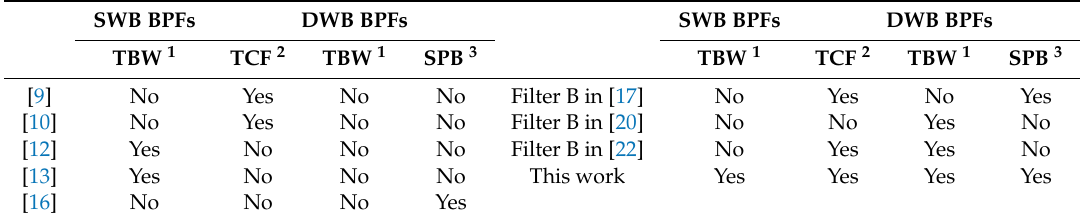
Figure 13. The photograph of the fabricated filter. Table 1. Simulated and measured results under different cases. Table 2. Comparison with previous